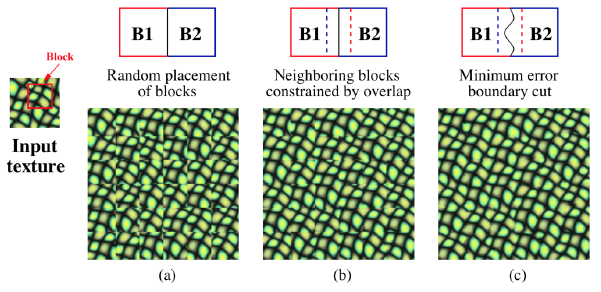
Fig. 2 The image quilting patch-based synthesis method [2]. Left: an input exemplar. Right: output imagery synthesis. (a) and (b) show the matching stage, where patches are selected by either (a) random sampling or (b) based on similarity to previously selected patches. (c) shows the blending stage, which composites and blends together overlapping patches. In this method, “blending” is actually done based on a minimal error boundary cut. Reproduced with permission from Ref. [2], c (cid:13) Association for Computing Machinery, Inc. 2001.